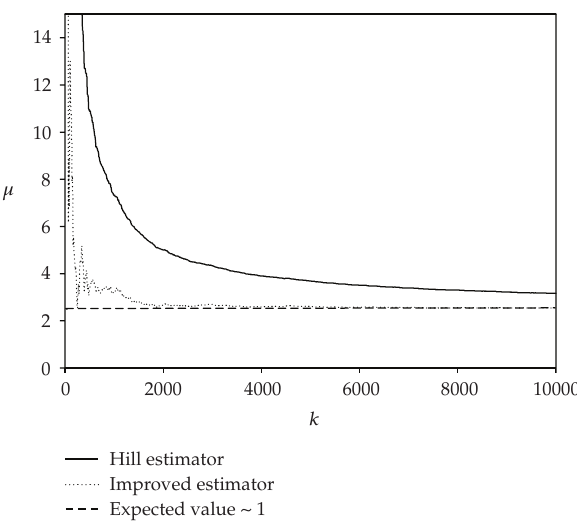
Figure 2: A sum of two power like behaviors (cid:5) see Example 15 (cid:6) .